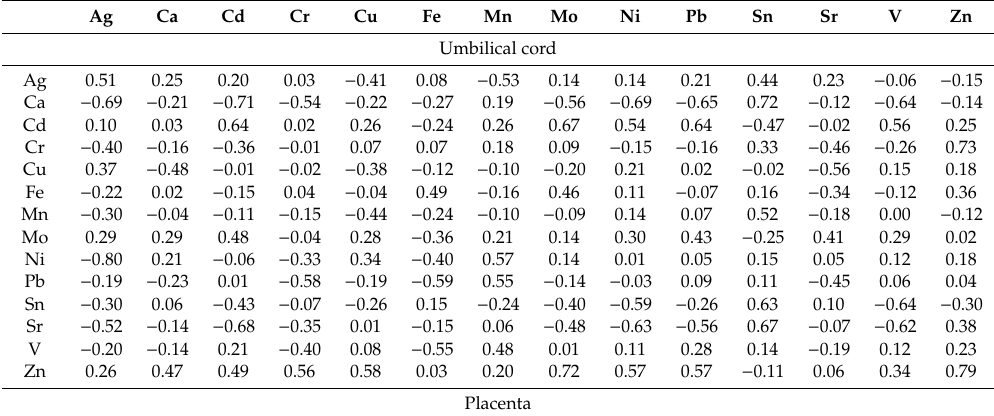
Table 6. Pearson’s correlation coe ffi cients for metals found in the fetal membrane ( p < 0.05). Ag Ca Cd Cr